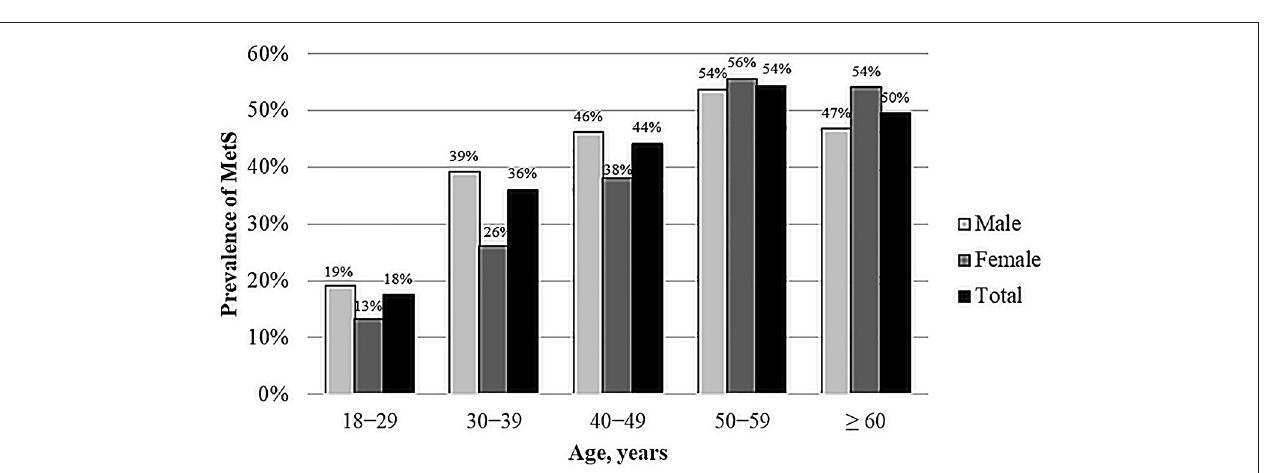
P-valuesinboldarestatisticallysignificant.BG,Bloodglucose;BP,Bloodpressure;HDL,High-densitylipoprotein;TG,Triglycerides;WC,waistcircumference;MetS,metabolicsyndrome.